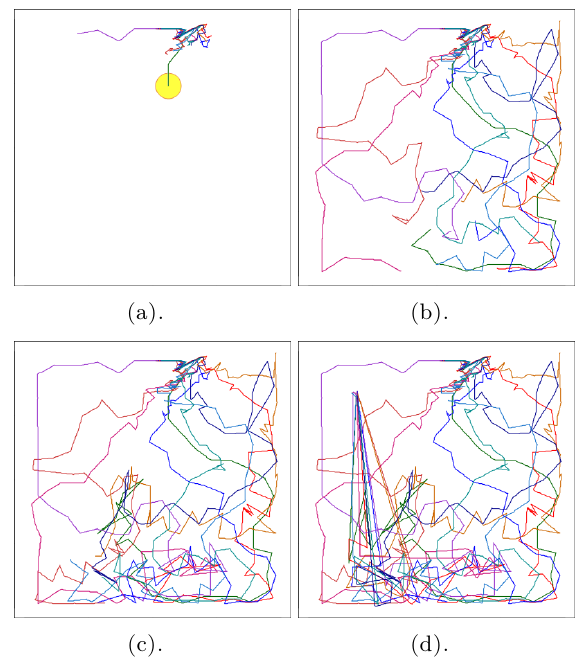
Figure 5. The passed paths for the team of 10 robots and the laser range is 20 meters at the step: (a) 80; (b) 580; (c) 800; (d) after finishing